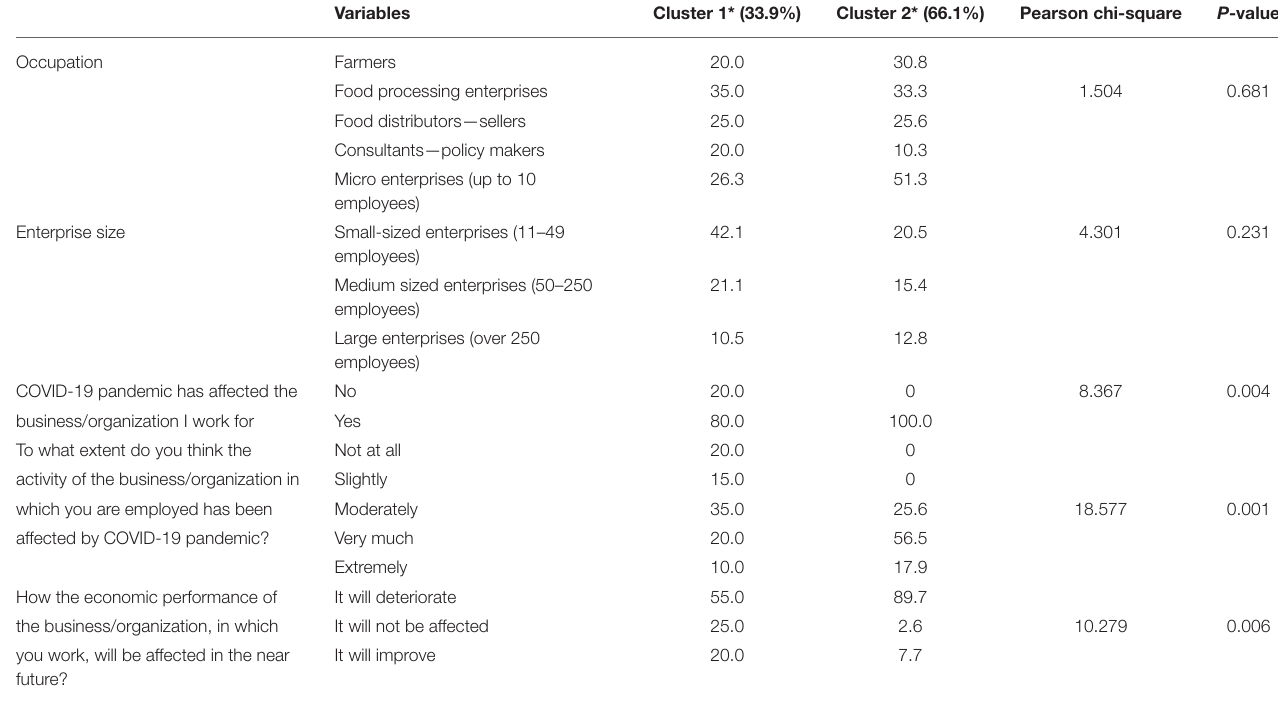
TABLE 11 | Cluster profile ( N =